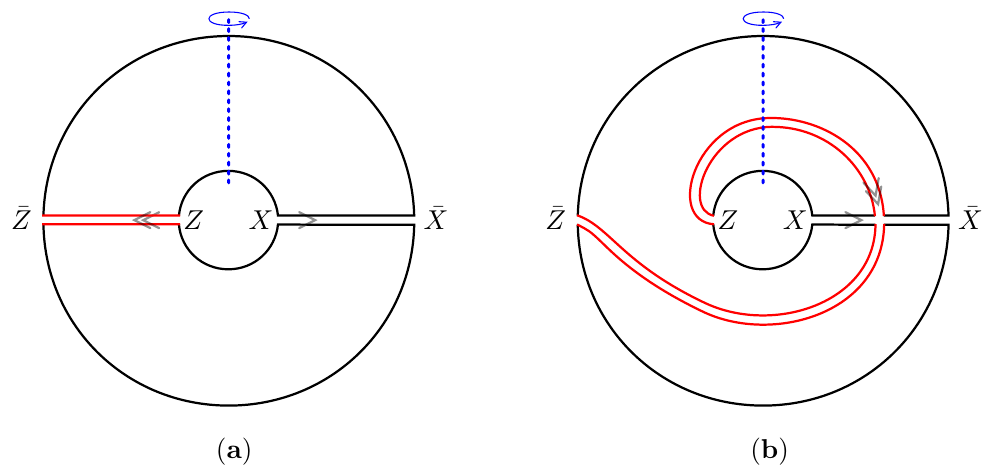
Figure 14 . ( a ) The unique tree-level diagram that contributes to the correlation function between a twisted operator of the type (5.1) and a conjugate operator from the same family. The diagram is plotted in double line notation, where the external and internal circles represent the colour-trace in (5.1). Here, we have made a conventional choice for the twist cut. ( b ) The unique one-loop diagram that contributes to the same